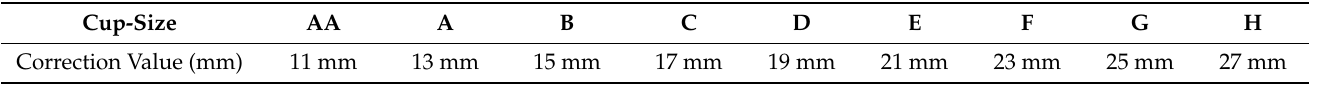
Table 6. Cup size to correction dimension between chest circumference and under bust circumference.